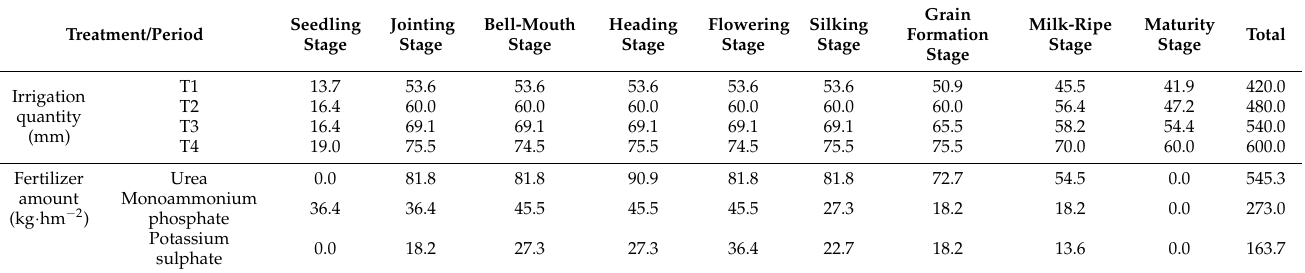
Table 3. Irrigation and fertilization in different periods.